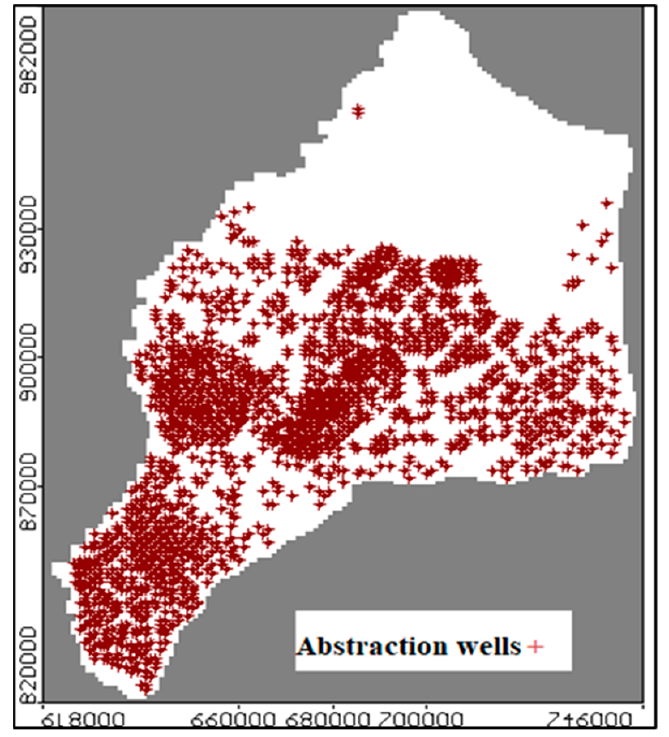
Figure A2. Location map of pumping wells distribution in the ENDA.